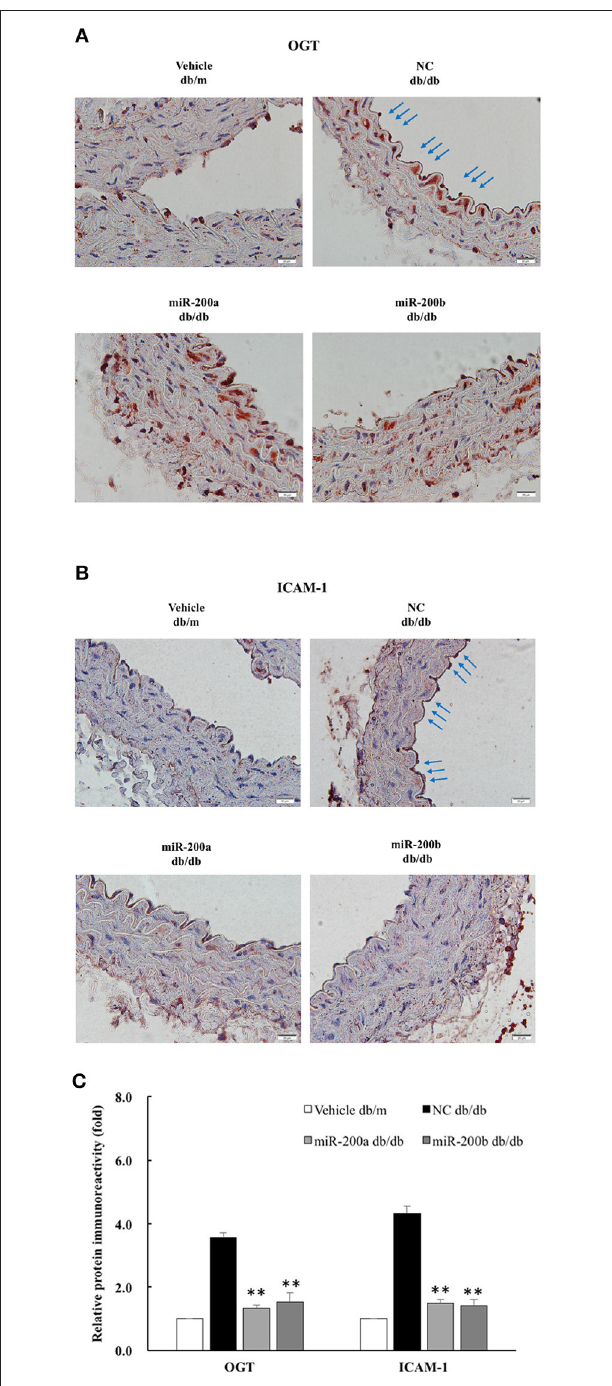
FIGURE 5 | miR-200a/200b mimic decreased endothelial OGT and ICAM-1 expression in type 2 db/db diabetic mice . Immunohistochemistry staining of (A) OGT and (B) ICAMI-1 in the thoracic aorta tissue. Representative images showing that the immunoreactivities of endothelial OGT and ICAM-1 in the aortic endothelial layers (blue color as arrow) were decreased in the miR-200a/200b mimic-treated db/db mice, as compared with the negative control (NC)-treated db/db mice. db/m mice: non-diabetic control mice. N = 3 per group. Scale bar = 20 µ m. (C) Immunoreactivity signals in endothelial layers from four treatment groups were quantified for all immunohistochemistry images. ** p < 0.01 compared to the db/db (NC) group.